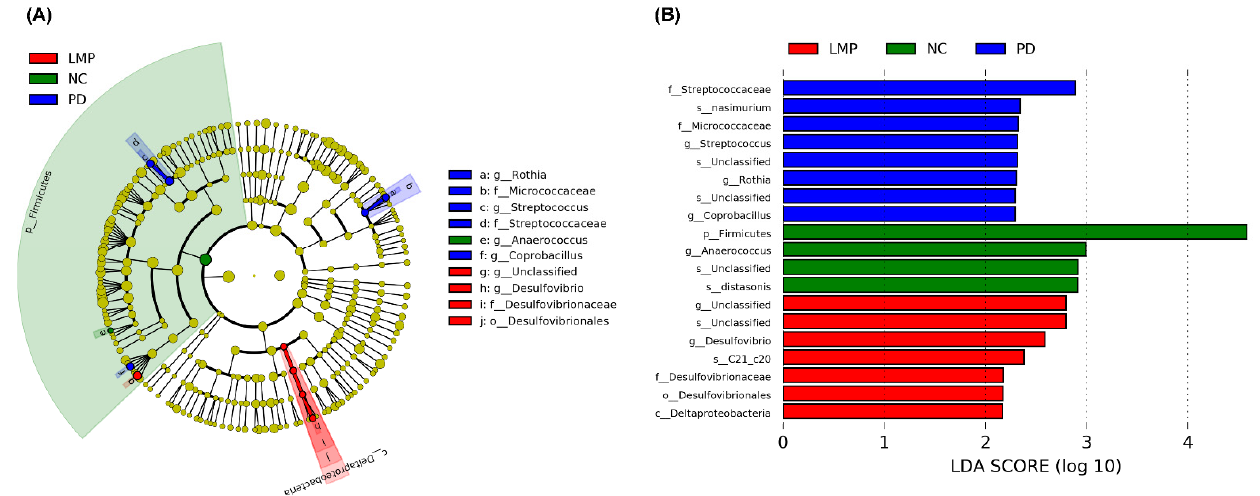
Figure 7. Linear discriminant analysis (LDA) effect size (LEfSe) of fecal microbiota enrichment in the normal control (NC), Parkinson’s disease (PD), low-dose mangosteen pericarp (LMP), and high-dose mangosteen pericarp (HMP) groups after 8 weeks of supplementation. ( A ) The circles of the phylogenetic tree cladogram demonstrate the classification of the fecal microbiota from the phylum to genus level. The diameter of the circles illustrates relative abundance. The typescripts A to J in A represent 10 different taxa. ( B ) LDA scores for differentially abundant taxa between the NC, PD, LMP, and HMP groups. Taxa with an LDA score >2 (log 10) were included in the LEfSe analysis. There was no distinct taxonomic enrichment between the HMP group and other groups; thus, the HMP group is not shown in the phylogenetic tree cladogram. C, class; F, family; G, genus; O, order; P, phylum.